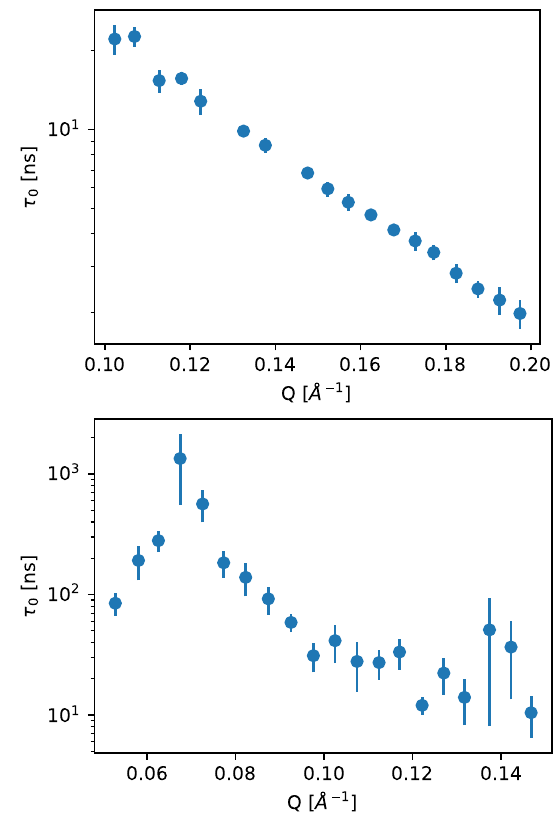
Figure 6. Di ff usion constant (i.e. 1 / ( τ 0 Q 2 ) for the bicontinuous (top) and lamellar (bottom)